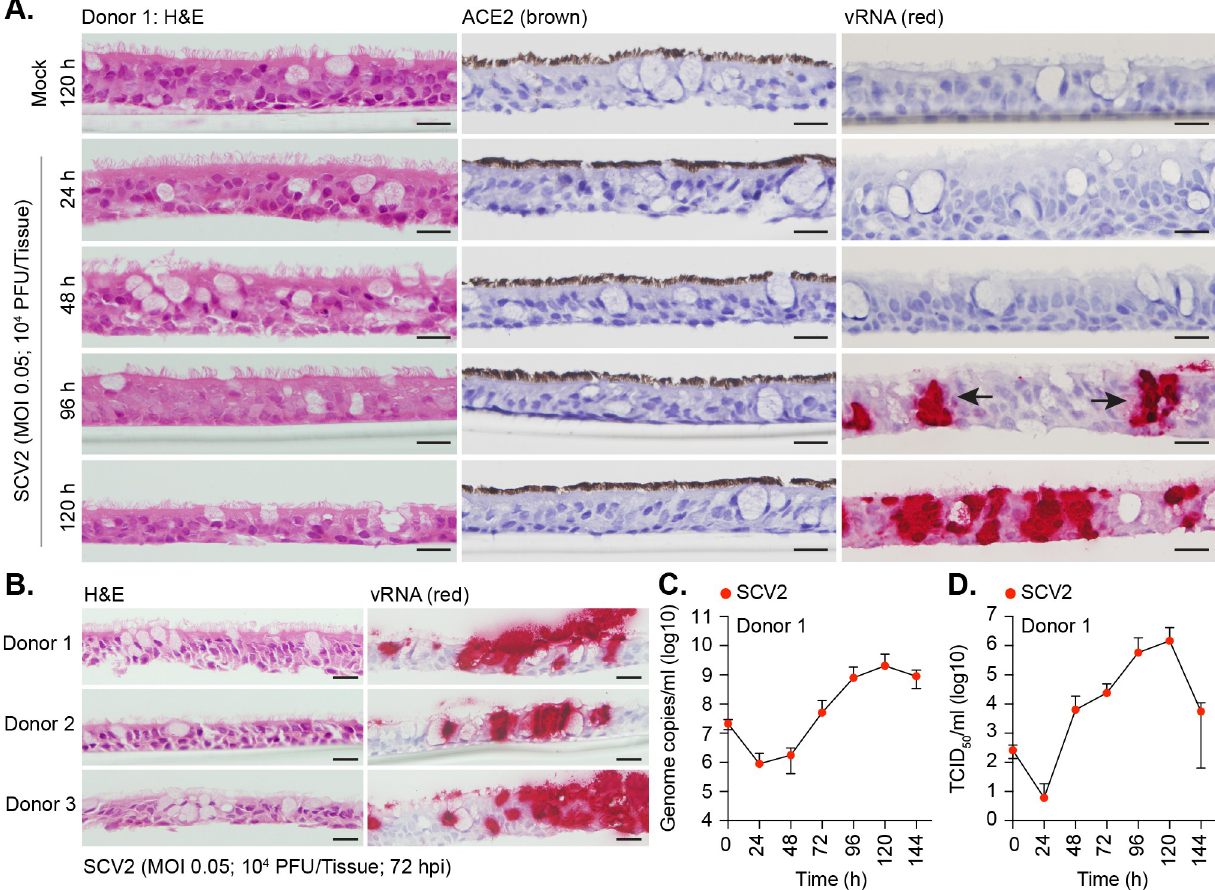
Fig 1. Differentiation of primary bronchial epithelial airway cultures supports SARS-CoV-2 replication. Primary bronchial epithelial cells isolated from 3 independent donors (donor 1, male Caucasian aged 63 years; donor 2, Hispanic male aged 62 years; donor 3, Caucasian female aged 16 years;